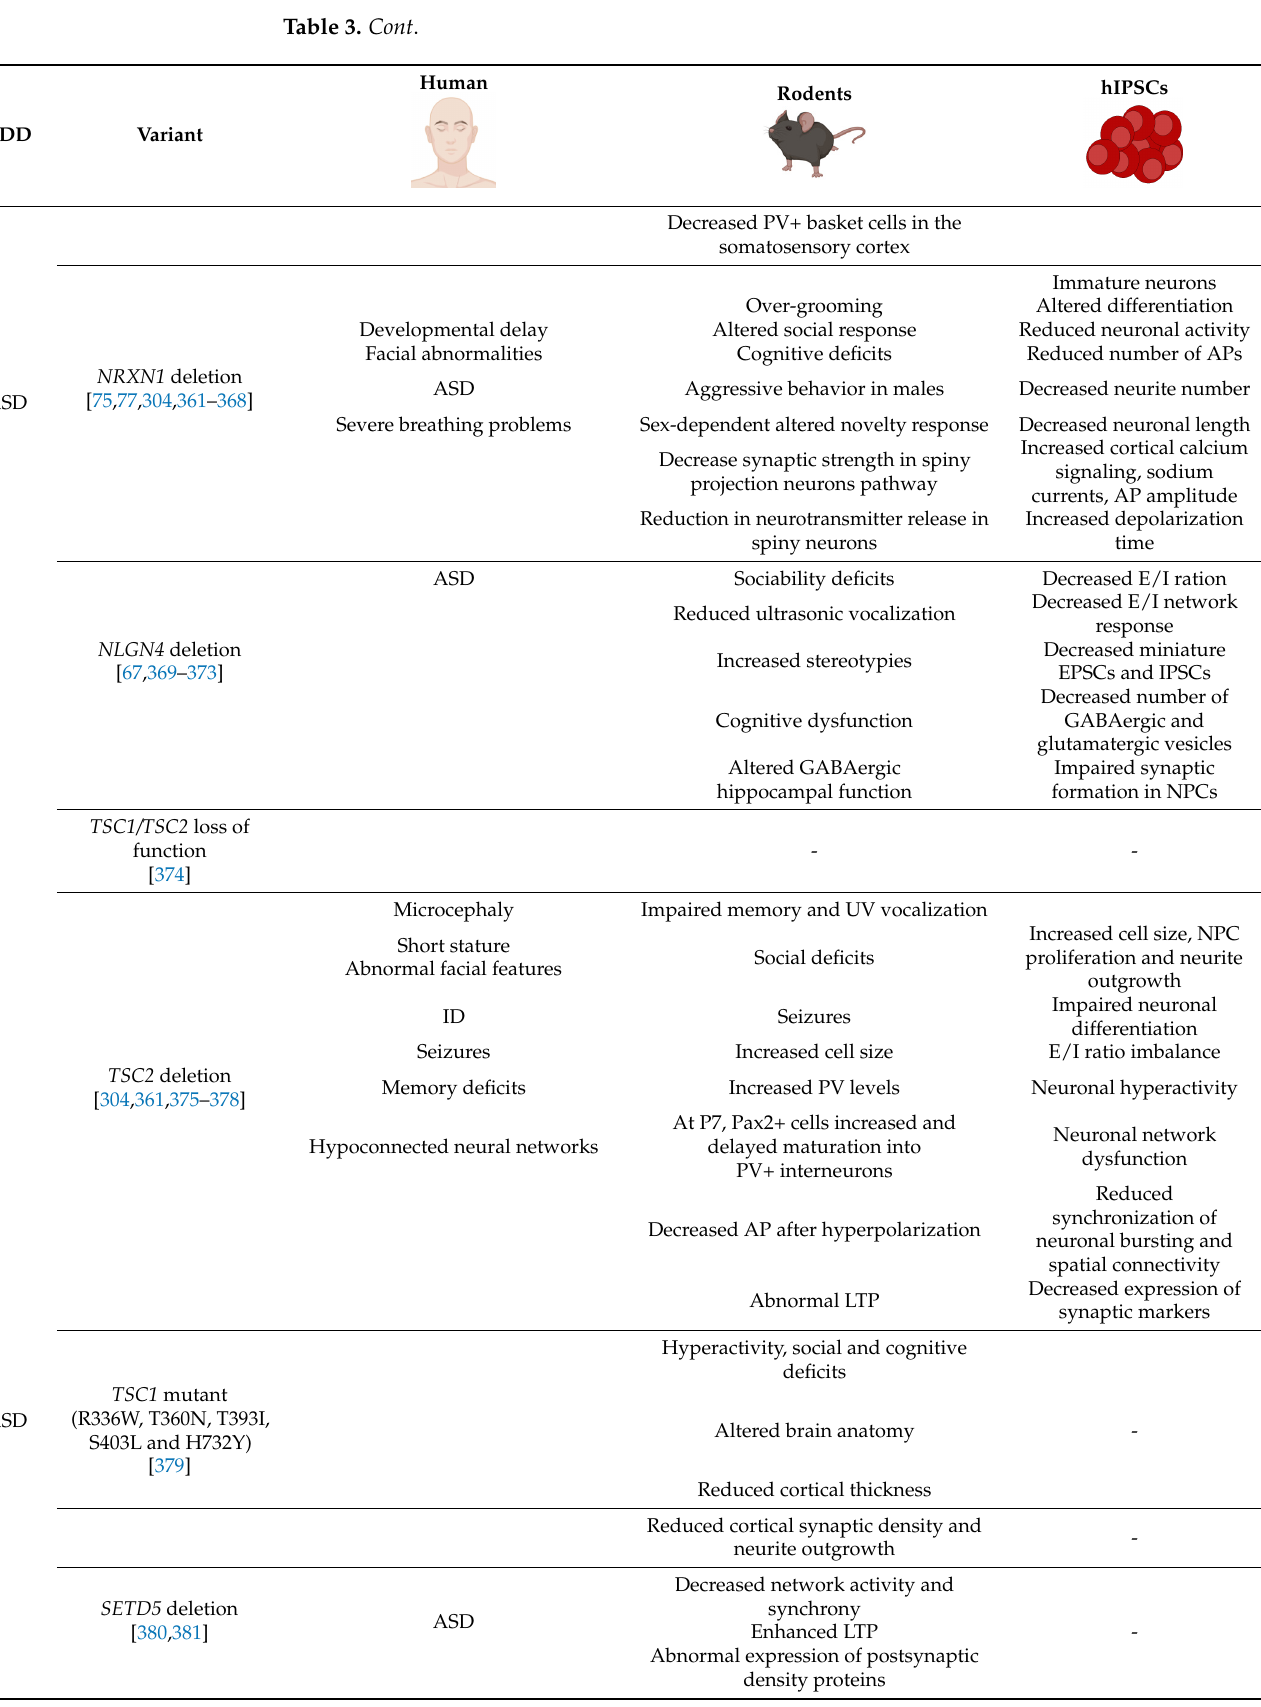
Table 3. Described ASD human, rodent and hIPSCs phenotypes.